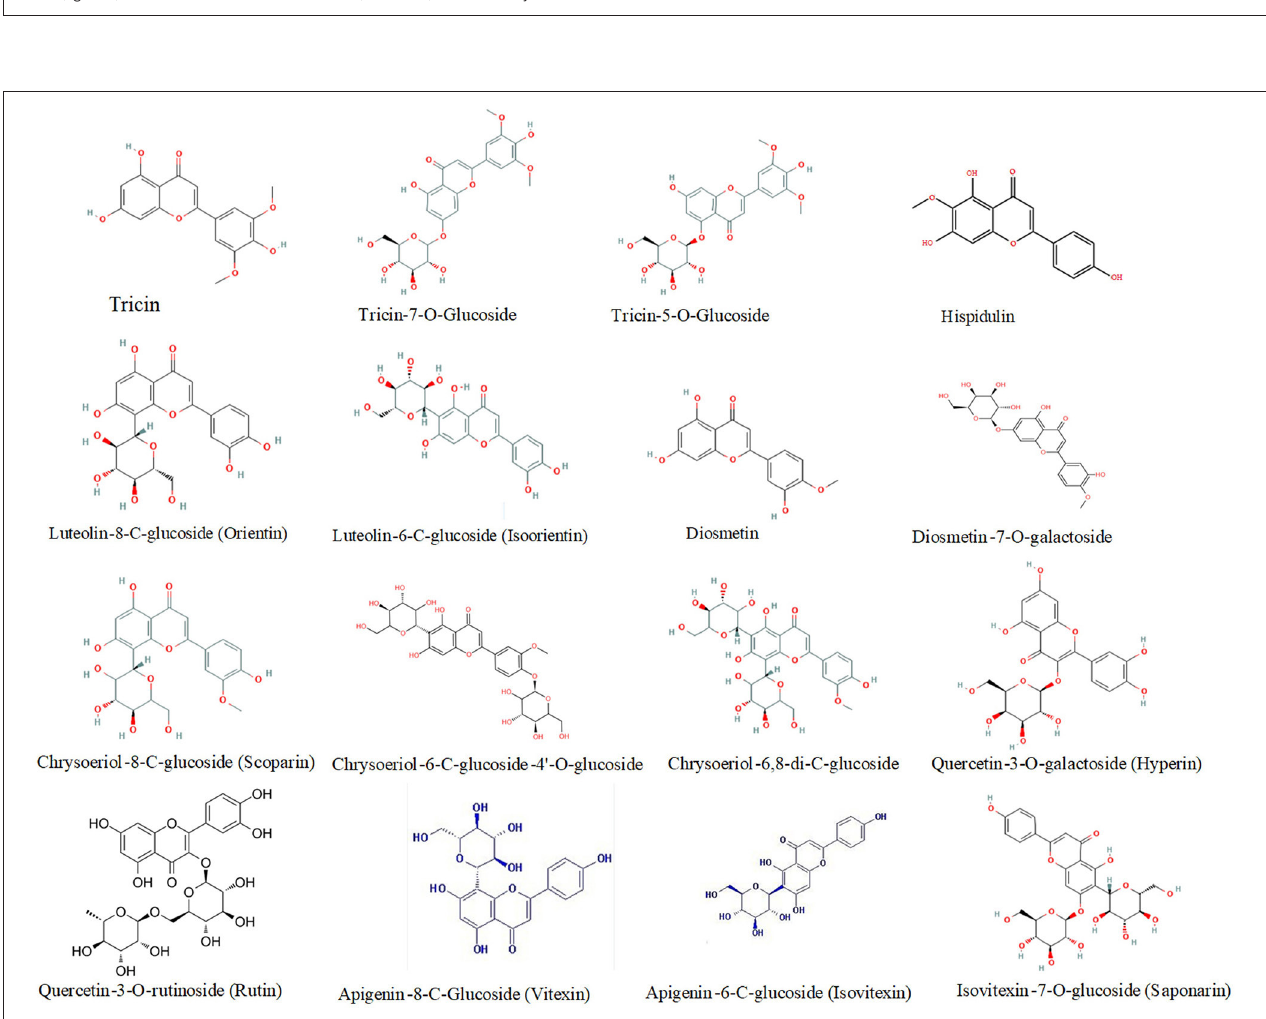
FIGURE 5 | The chemical structure of differentially expressed flavonoid components between HPm512 and ZM22.